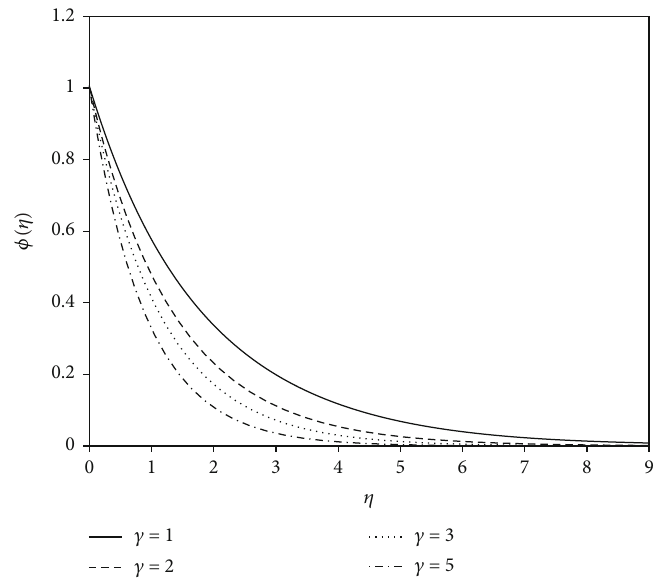
Figure 6: Di ff erent values of chemical reaction γ on the concentration pro fi